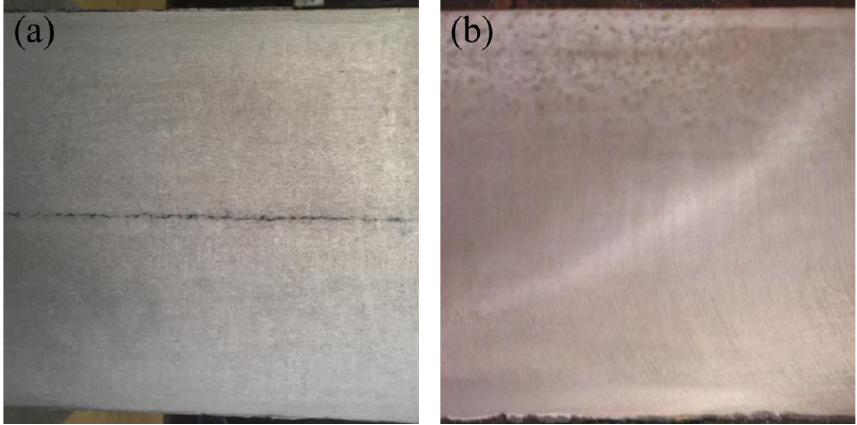
Figure 13. The slab before and after optimization: ( a ) before optimization; ( b ) after optimization.